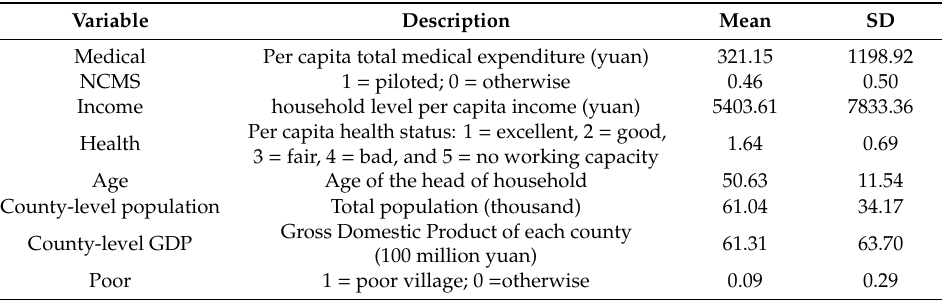
Table 2. Description of the Variables (2003 to 2007).